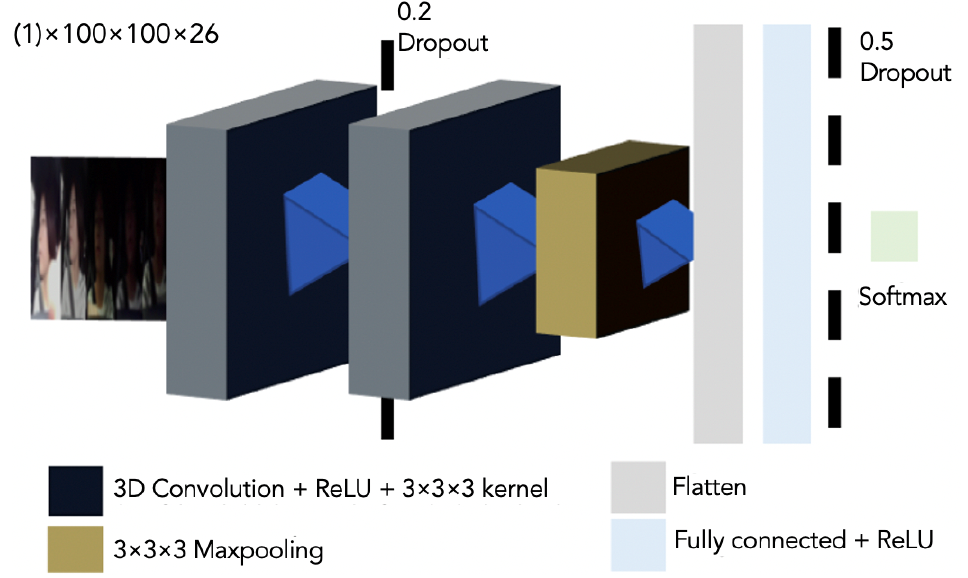
Figure 3. Three-dimensional CNN architecture used to predict the six different proposed standard driving gaze areas with a one-channel (1) sequence of frames